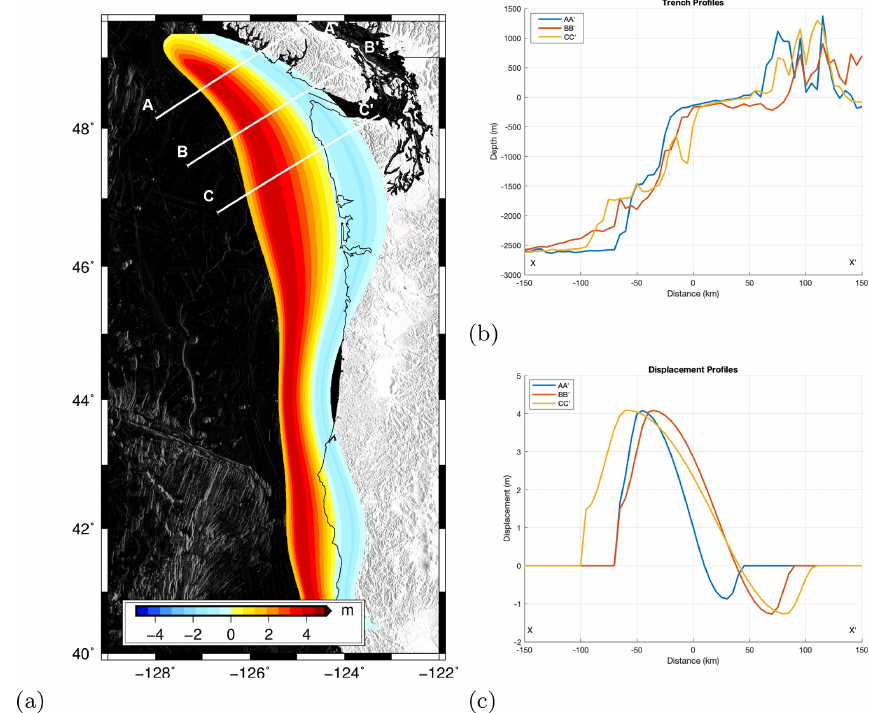
Figure 6. Top view of the seabed deformation for trial no. 24 (a) and profiles of the trench (b) and vertical displacement (c) .